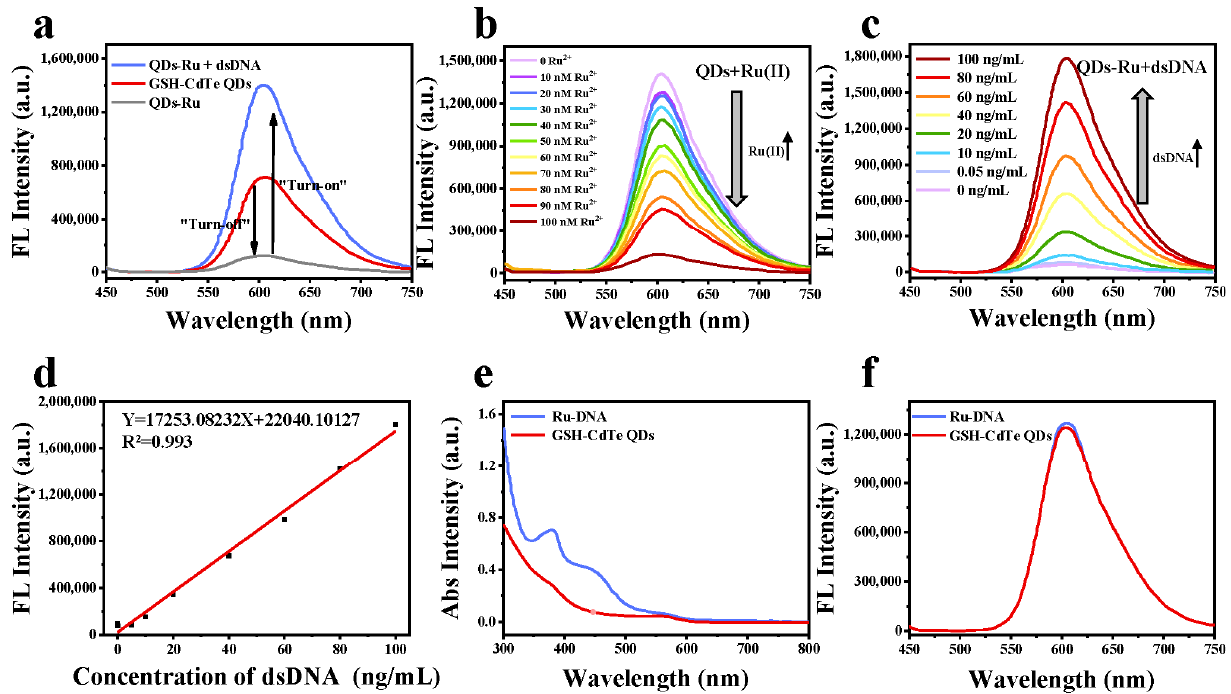
Figure 3. The fluorescent “turn-on” properties of the QDs-Ru complex. ( a ) The fluorescence quench- ing and recovery of QDs because of the Ru(II) complex and dsDNA interaction. ( b ) The fluorescence of GSH-CdTe QDs was quenched gradually with the increase of the Ru(II) complex’s concentration. ( c ) The fluorescence of GSH-CdTe QDs was recovered gradually with the increase of the concentra- tion of dsDNA. ( d ) The linear relationship between the concentration of dsDNA and the recovered fluorescence intensity. The limit of detection is 0.06 ng/mL for dsDNA ( S / N = 3). ( e ) The fluorescence spectrum and UV-vis absorption of GSH-CdTe QDs and Ru-dsDNA. ( f ) GSH-CdTe QDs and Ru- DNA complexes have similar emission wavelengths at the same excitation wavelength (ex: 390 nm, em: 605